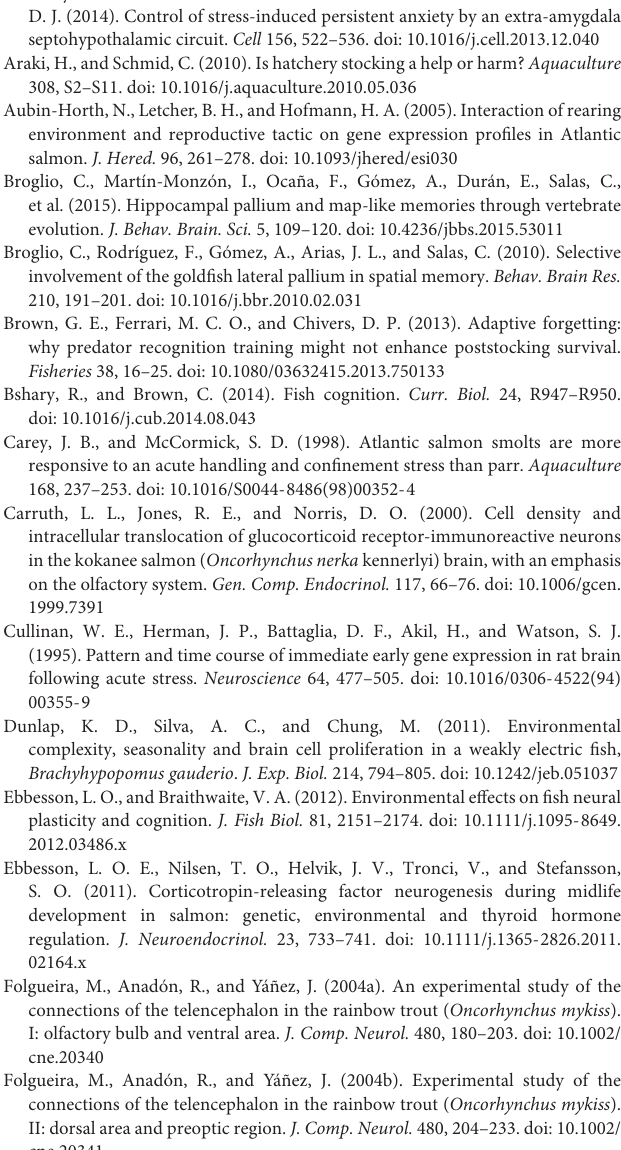
FIGURE S1 | Specificity of the riboprobes was verified by performing the in situ hybridization protocol using both sense and antisense probes on a subset of brain samples. Depicted are the sense (A) and antisense (B) probes for bdnf and the sense (C) and antisense (D) probes for cfos . FIGURE S2 | Illustration of several steps of the semi-automated quantification method of transcript-positive cells. The area of interest was selected using the